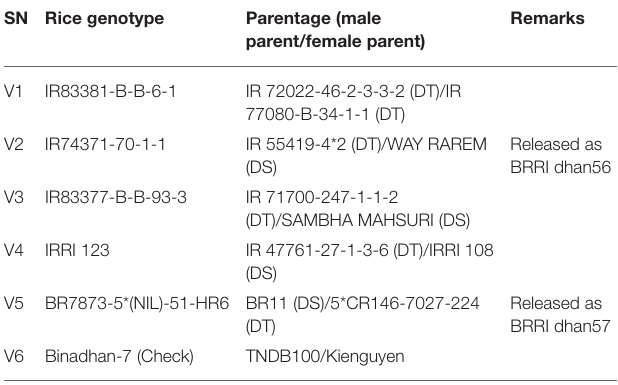
TABLE 2 | Rice genotypes used in this study.